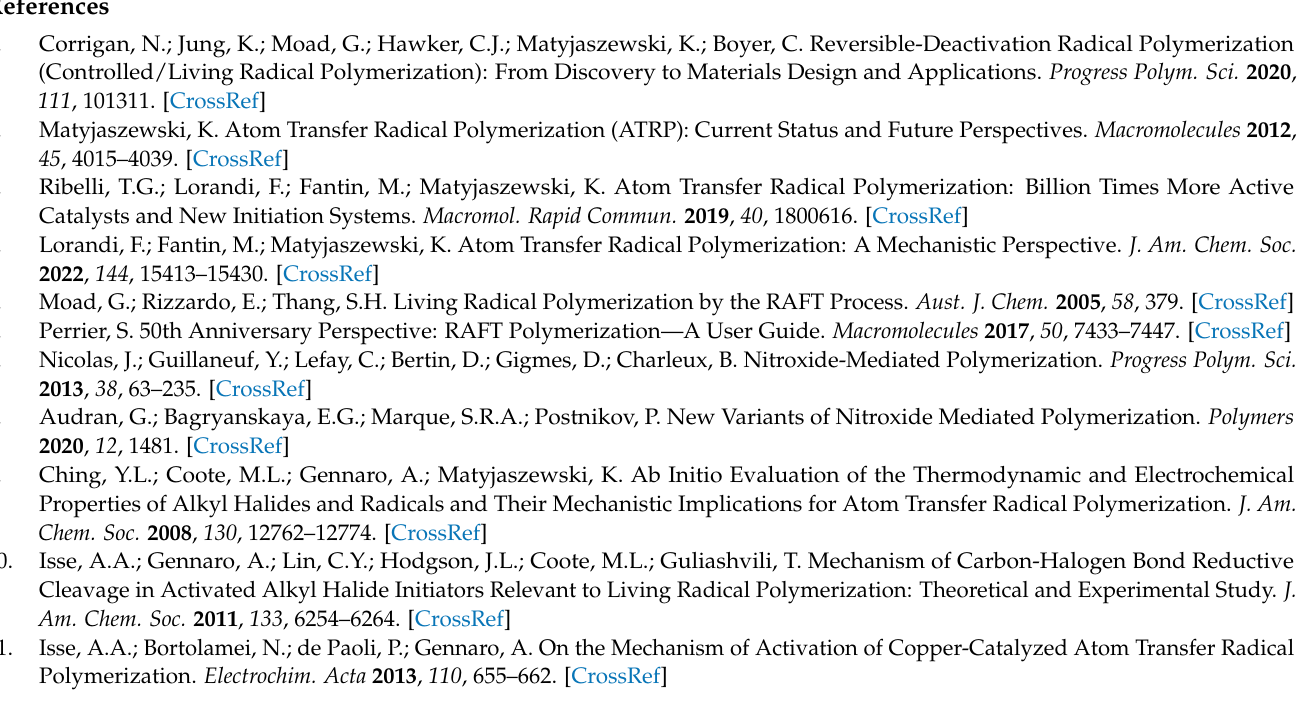
(solid line) for the determination of k ◦ in DMF + 0.1 M Et 4 NBF 4 at T = 25 ◦ C; Figure S6: UV-vis spectra of 0.1 mM FeCl 3 , 0.2 mM TPP and a mixture of 0.1 mM FeCl 3 + 0.2 mM TPP, in DMF; Figure S7: presence of triphenylphosphine (TPP) at v = 0.2 V/s and T = 25 ◦ C; Figure S8: CV of 1.1 mM FeCl 3 in addition of TPMA and Et 4 NCl; Figure S9: CV of 5 mM Fe III L(Cl) in DMF/MMA (50/50, V/V ) + 0.1 M Et 4 NBF 4 recorded on a GC electrode at v = 0.2 V/s and T = 50 ◦ C, in the absence (black line) and pres- ence of 15 mM ECPA (blue line) or 15 mM EBPA (red line); Figure S10: GPC traces of PMMA samples taken at different monomer conversions during e ATRP of mMA mediated by Fe III L(Cl) in DMF/MMA (50/50, V/V ) + 0.1 M Et 4 NBF 4 with EBPA as initiator performed at 50 ◦ C and E app = E p + 0.06 V; Figure S11: CV of 11.75 mM FeCl 3 in DMF/MMA (50/50, V/V ) + 0.1 M Et 4 NBF 4 recorded on a GC electrode at v = 0.2 V/s and T = 55 ◦ C, in the absence (black line) and presence of 47 mM EBPA (red line); Figure S12: 1 H NMR spectrum (300 MHz, CDCl 3 ) of 2-pyridylamino- N , N -bis(2-methylene -4,6-dichlorophenol); Table S1: 1 H NMR spectral data of 2-pyridylamino- N , N -bis(2-methylene-4,6 -dichlorophenol; Table S2: Elemental analysis of chloro(2-pyridylamino- N , N -bis(2-methylene-4,6 -dichlorophenolate))iron(III). Ref. [60] is cited in Supplementary